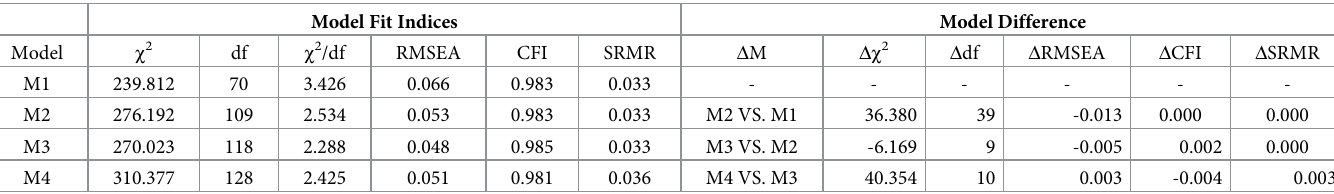
Table 4. Model fit indices for measurement invariance